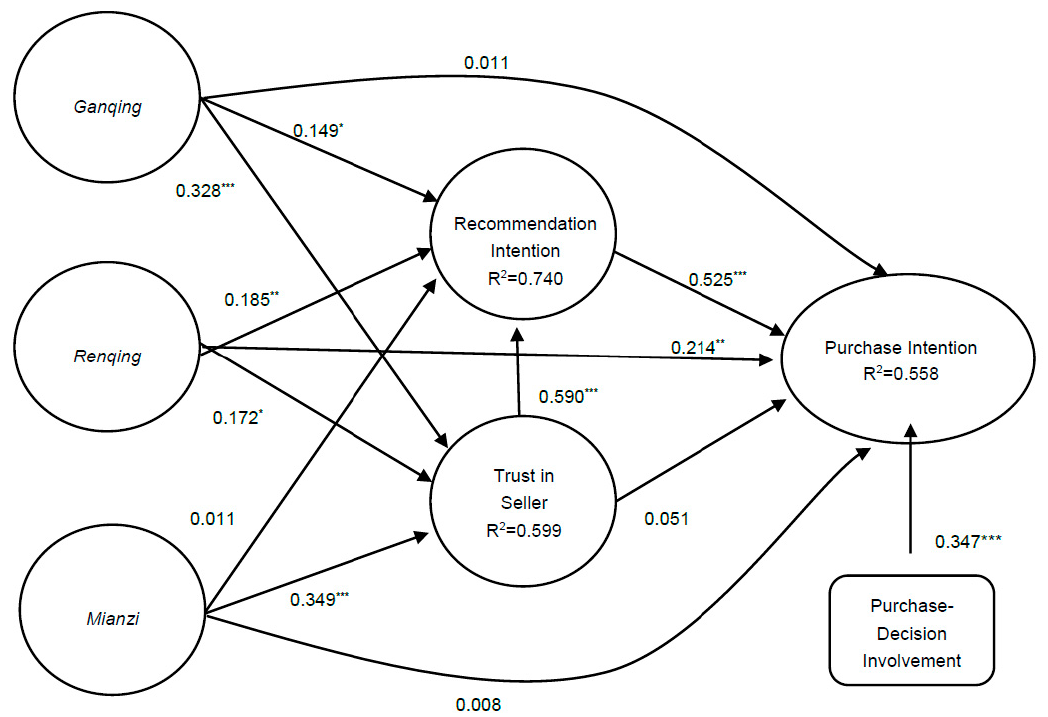
Figure 2. Path diagrams (*** p < 0.001; ** p < 0.01; * p < 0.05).